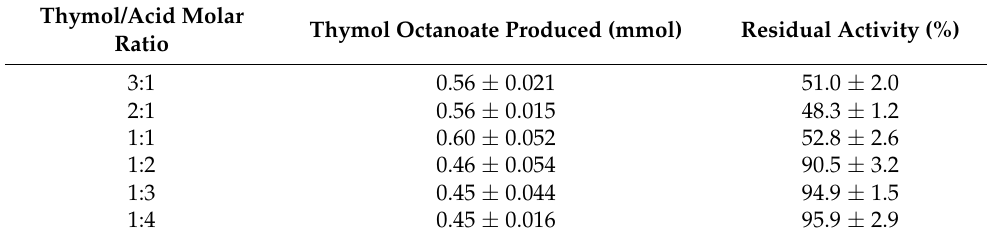
Table 5. Thymol octanoate production for different thymol/octanoic acid molar ratios and residual lipase activity after use. Reaction conditions: 2 mmol of octanoic acid, 200 µ L of CALB solution, 50 ◦ C, and 24 h of